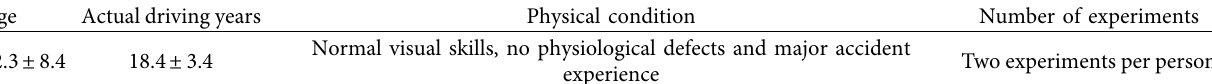
Table 2: Volunteer information.